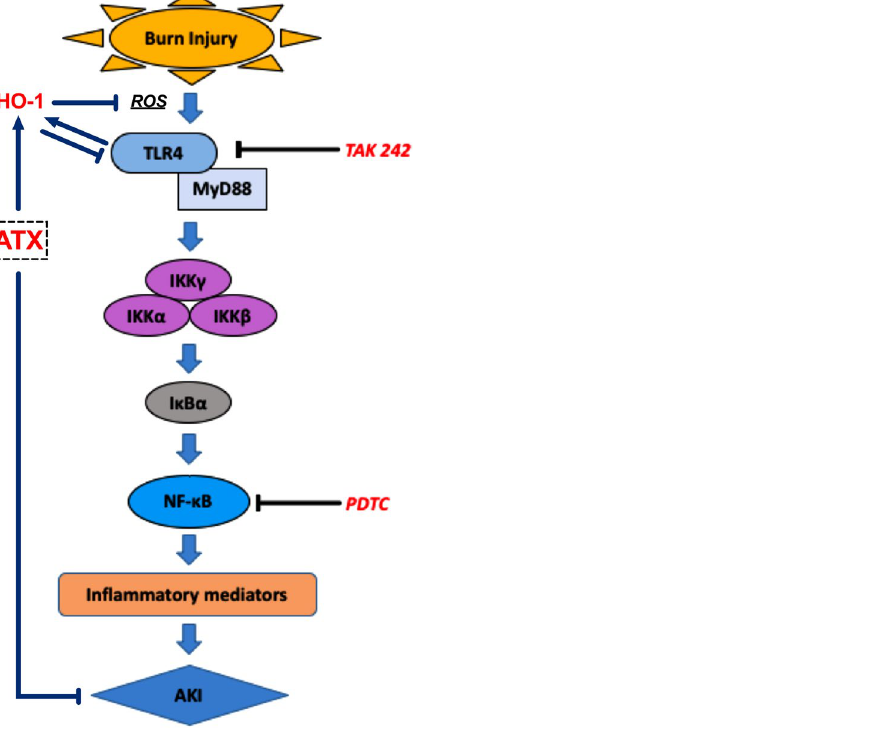
Figure 8. The schematic diagram of this